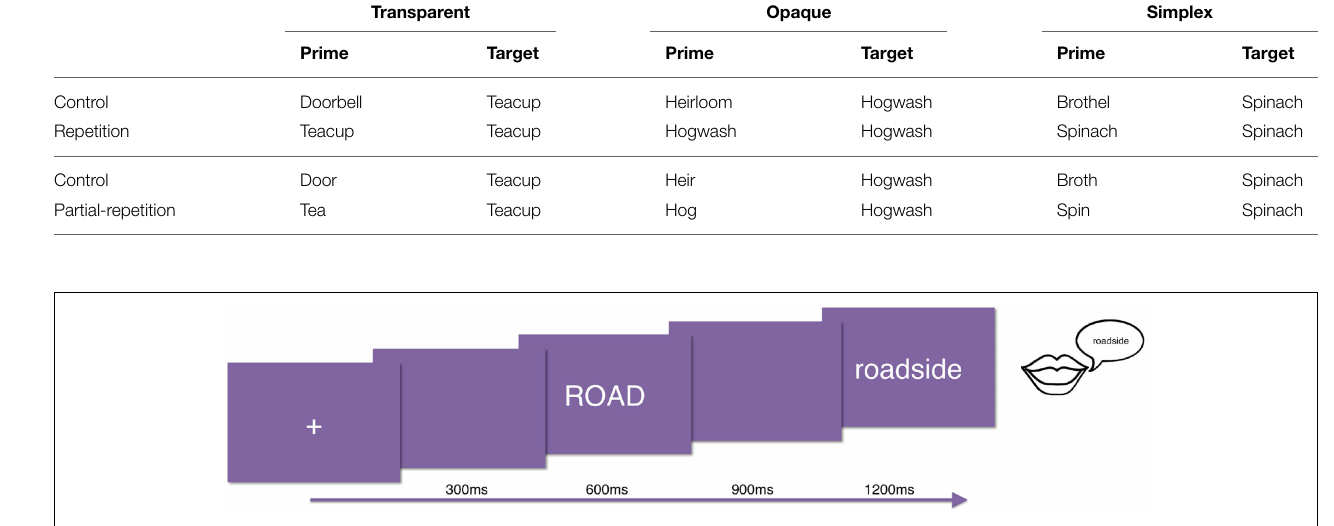
FIGURE 1 | Experiment trial